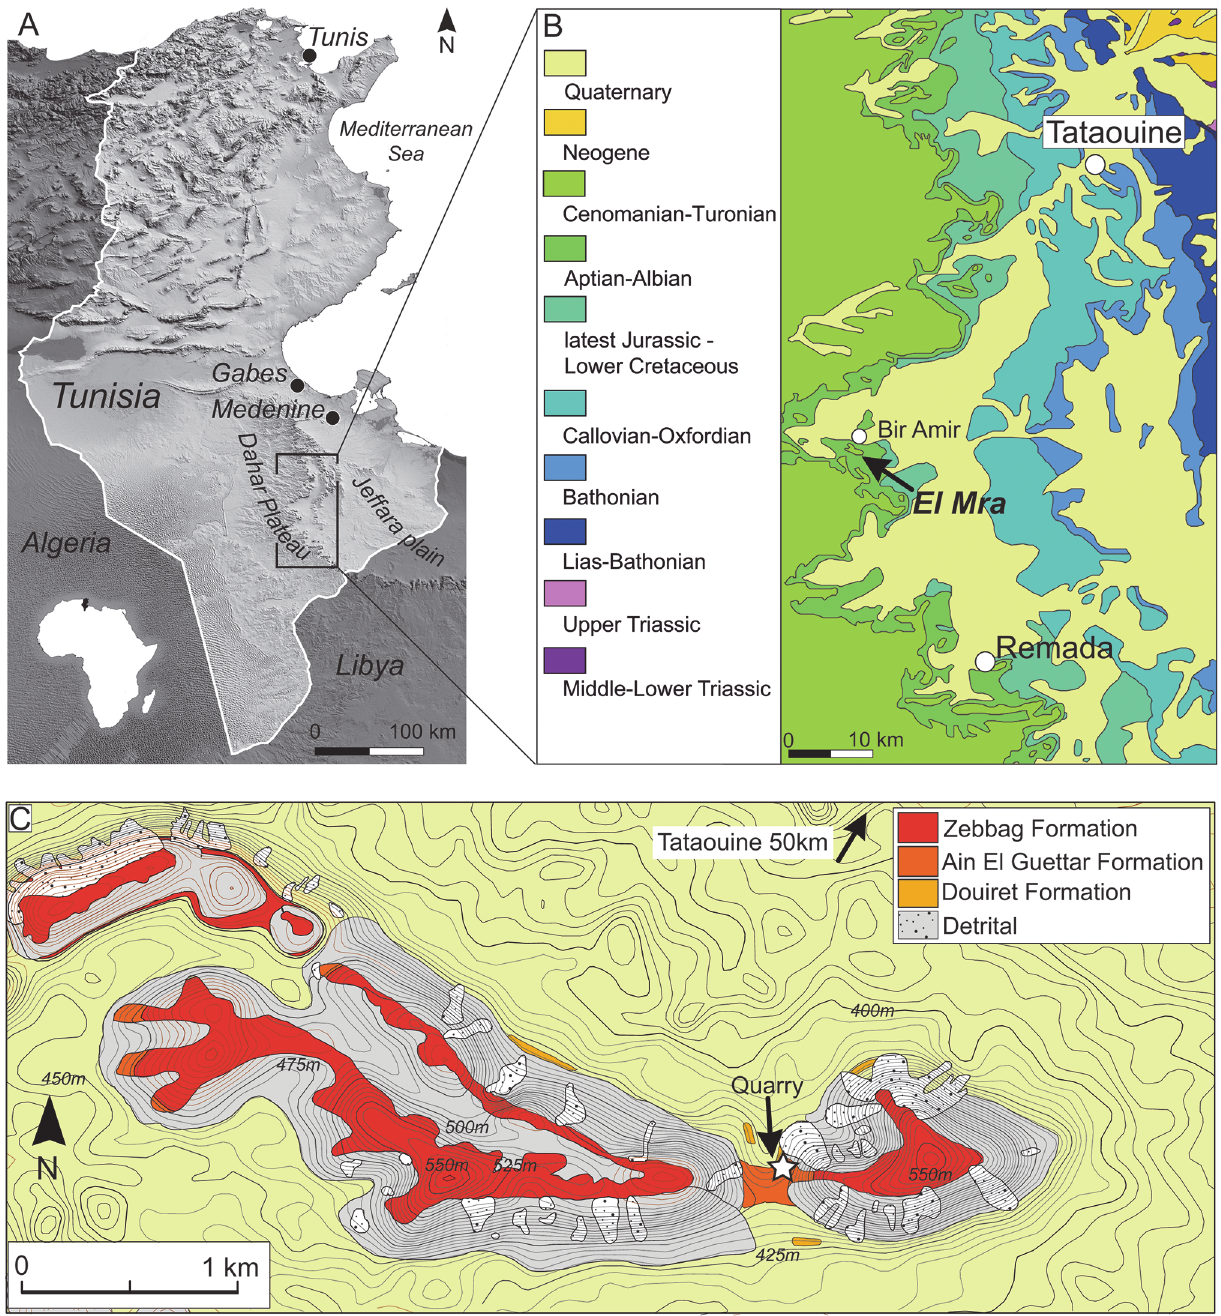
Fig 1. The Tataouine basin in southern Tunisia. A, reference map of the Tataouine region in southern Tunisia; B, simplified geological map of the study area showing the distribution of Mesozoic deposits and the El Mra locality near the village of Bir Amir. C, detailed topographic and geological map of the El Mra